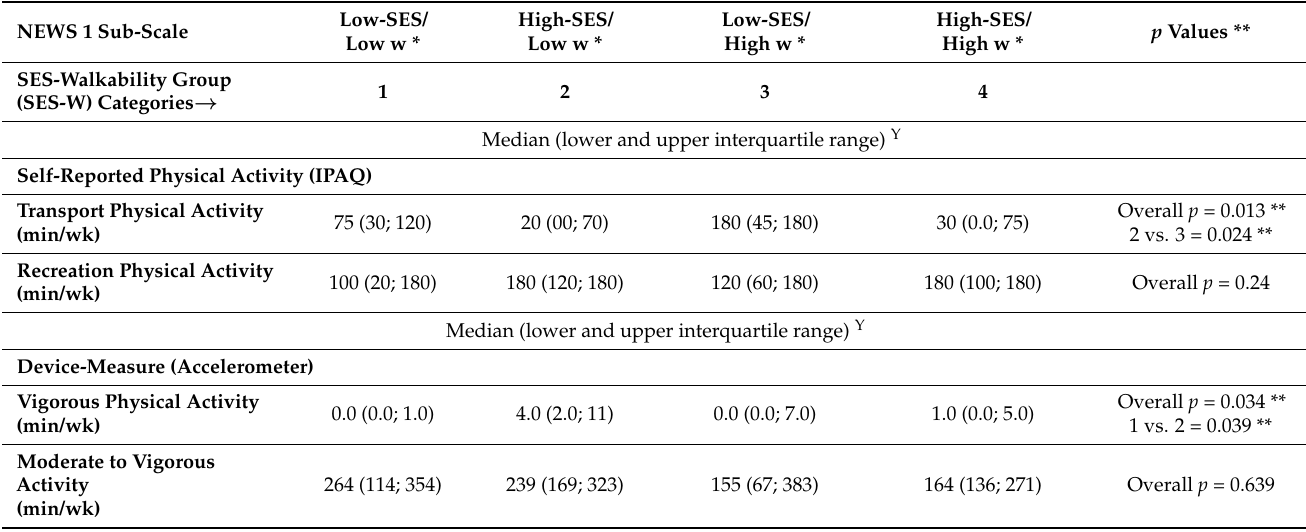
Table 4. Comparisons of self-reported and device-measured physical activity by SES-walkability status (low-high SES and low-high walkability) a